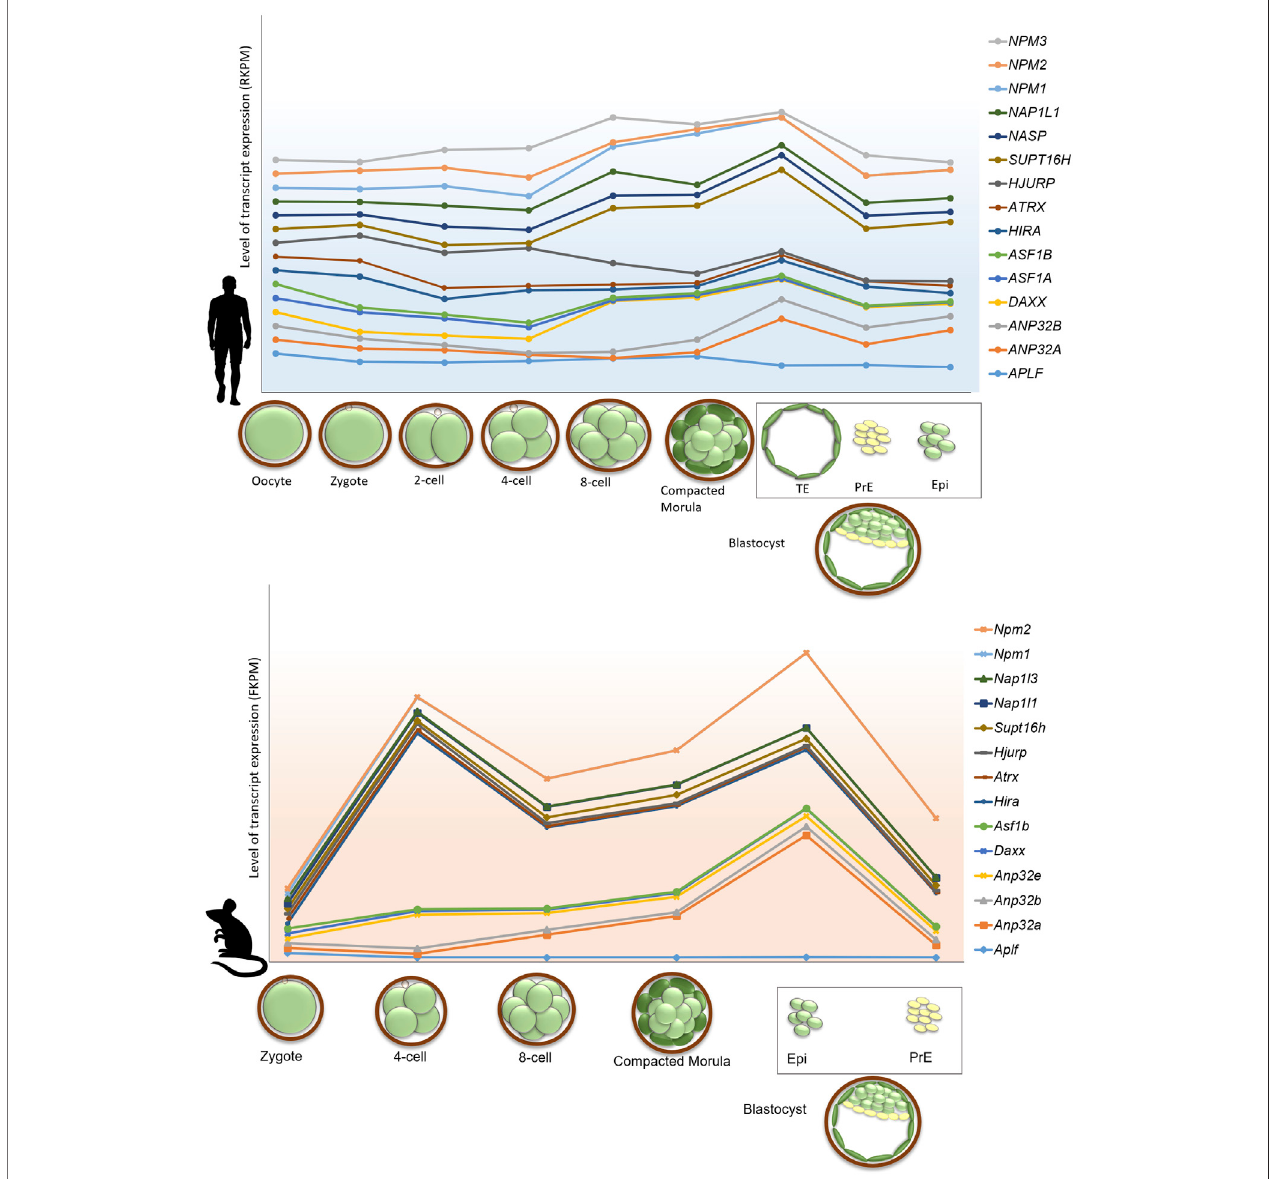
FIGURE 5 | Gene expression pro fi le of histone chaperones in pre-implantation stages in human and mouse embryo. Gene expression of histone chaperones between human and mouse exhibits difference in the expression pattern in different stages ofpre-implantation embryos. Transcriptome pro fi le of histone chaperones in pre-implantation stages of mouse (lower panel) and human (upper panel) embryos were extracted from and Boroviak et al., 2018 and Yan et al., 2013. Expression of histone chaperones inpre-implantation embryos were normalized with respect to oocyte and zygote in human and mouse, respectively.The X -axis represents the pre-implantation developmental stages; Y -axis represents the level of transcript expression of different chaperones. The level of transcript expression is represented in RPKM (Reads per kilobase of transcript per million reads mapped) inhuman and FPKM (Fragments per kilobase of transcript per million reads mapped) in mouse. The box represents cell types derived from blastocyst stage of the embryo. Abbreviations-TE, Trophectoderm; PrE, Primitive, Endoderm; Epi, Epiblast.